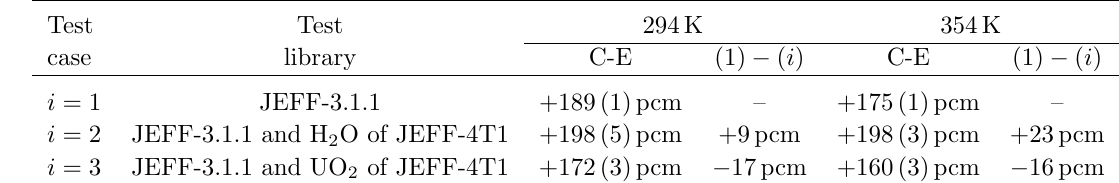
Table 3. Differences between the calculated (C) and experimental (E) reactivities obtained for the MISTRAL-1 core with the Monte-Carlo code T ripoli -4 (cid:114) . The digits in parentheses are the statistical uncertainty due to the Monte-Carlo calculations.